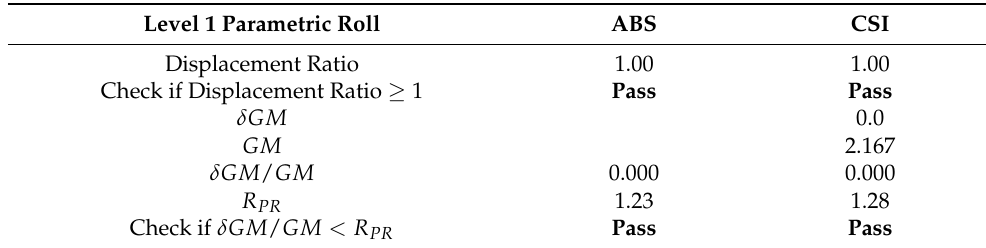
Table 11. Level 1 assessment of parametric roll failure mode for barge.